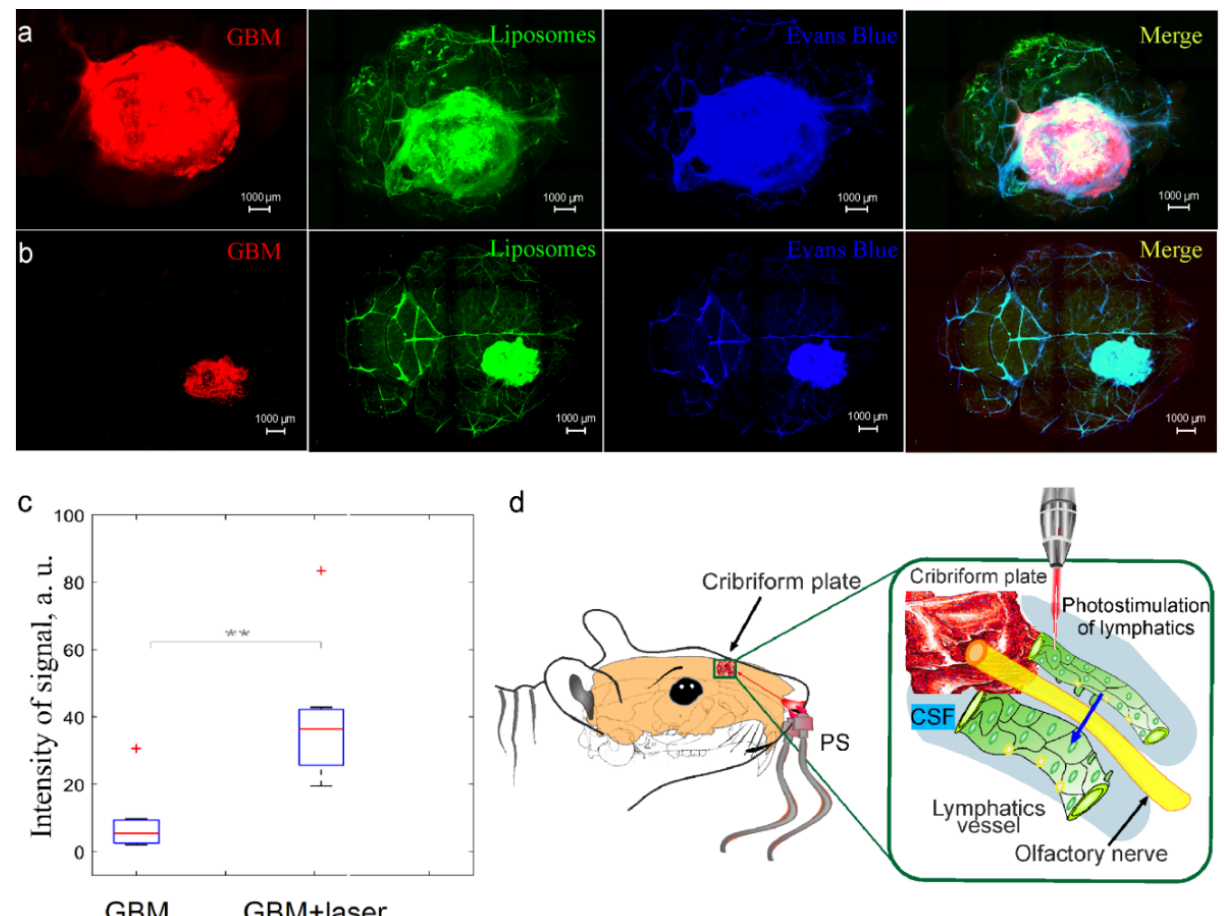
Figure 4. ( d ) Photostimulation of intranasal delivery of liposomes to GBM: ( a , b ) Representative images of the mouse brain with GBM (red, Ex 561/Em 570–620) 3 h after intranasal administration of liposomes (green, Ex 488/Em 500–550) in mice not treated ( a ) and treated by laser ( b ), the blood vessels were filled with the Evans Blue dye (blue, Ex 640/Em 663–738); ( c ) the quantitative analysis of fluorescent signal from liposomes (a.u.) in the GBM tissues in the GBM + laser and the GBM groups, n = 7 in each group, ** p < 0.01, the Mann–Whitney–Wilcoxon test, the outliers of experimental data are plotted using the ‘+’ symbol.